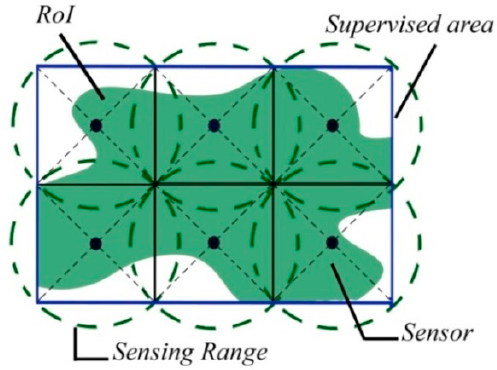
Figure 4. Graph scenario of dividing an area into cover sets.